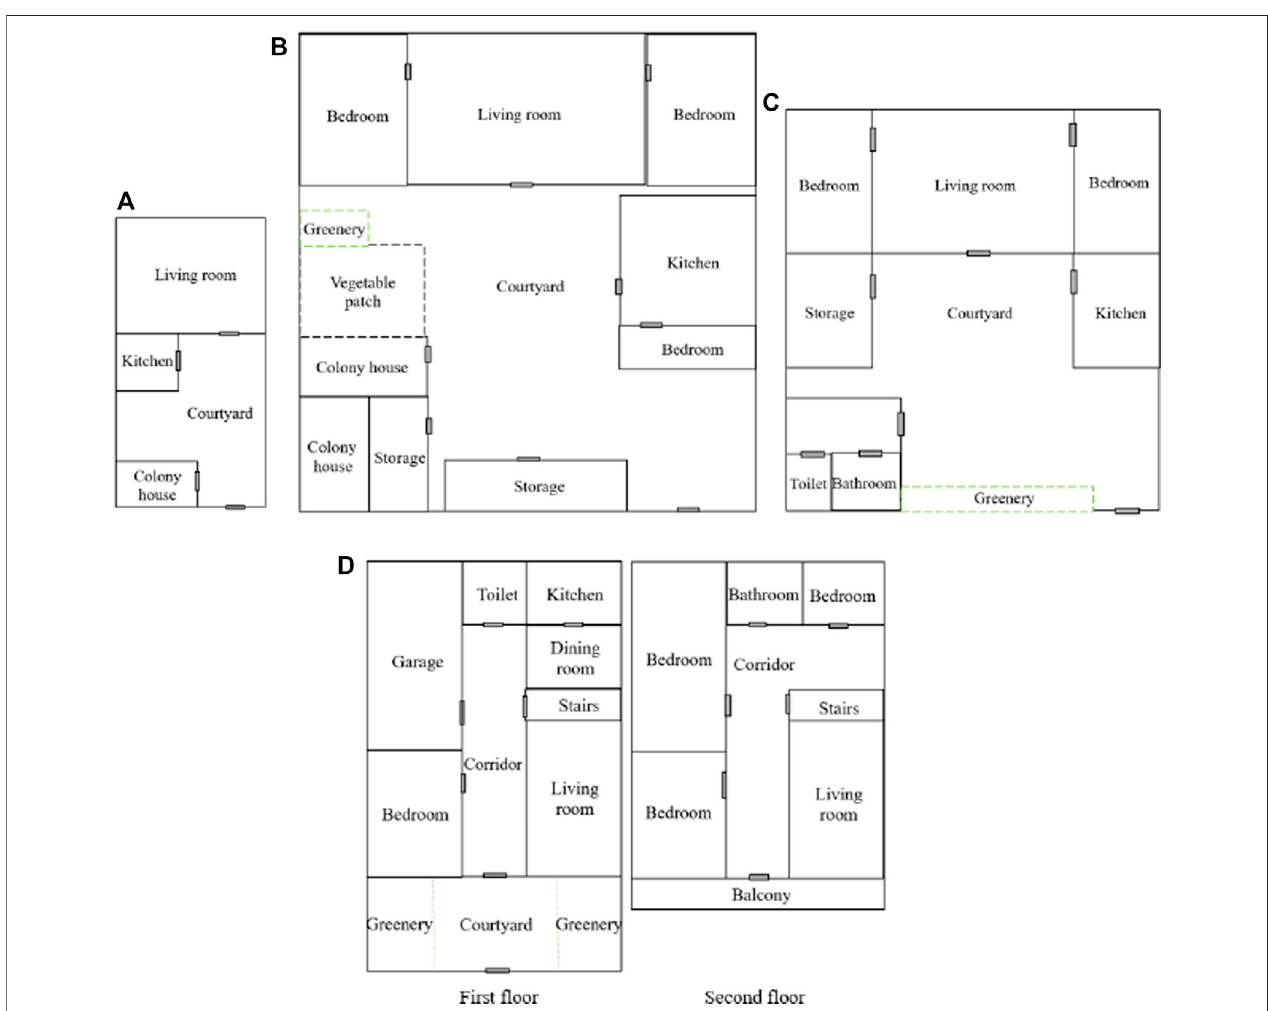
FIGURE 3 | Internal structure of different types of rural homesteads: (A) adobe house; (B) mud-brick house; (C) brick house; (D) building; dotted lines represent un fi xed, open space.